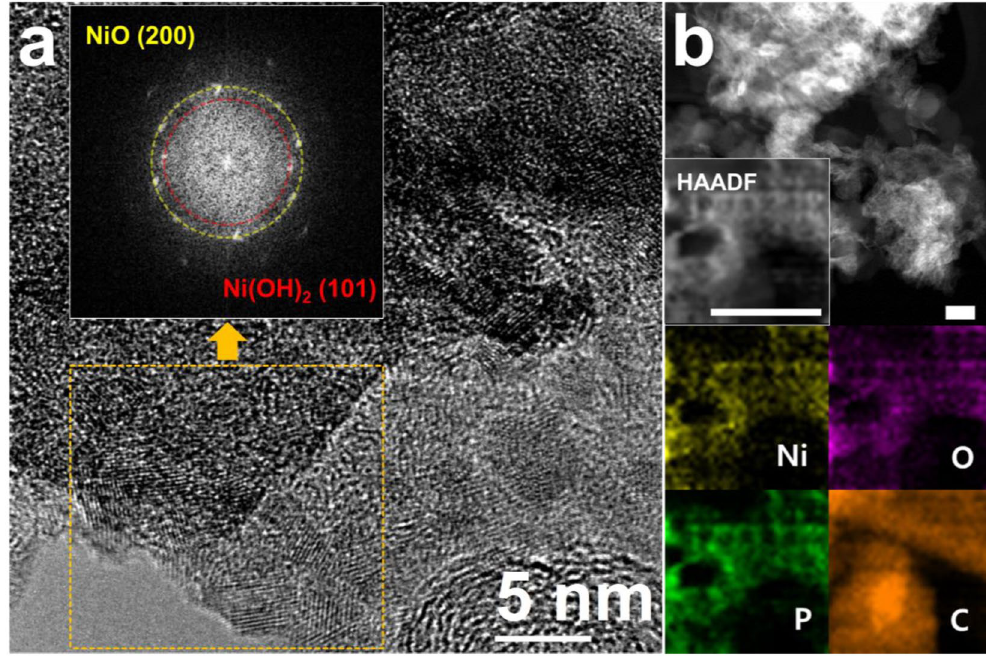
Figure 4. ( a ) High-resolution TEM image of Ni-O (orange dotted square) with a corresponding fast Fourier transform (FFT) pattern (inset figure), and ( b ) high-angle annular dark field (HAADF) images and elemental mapping using energy dispersive X-ray spectroscopy (EDS).